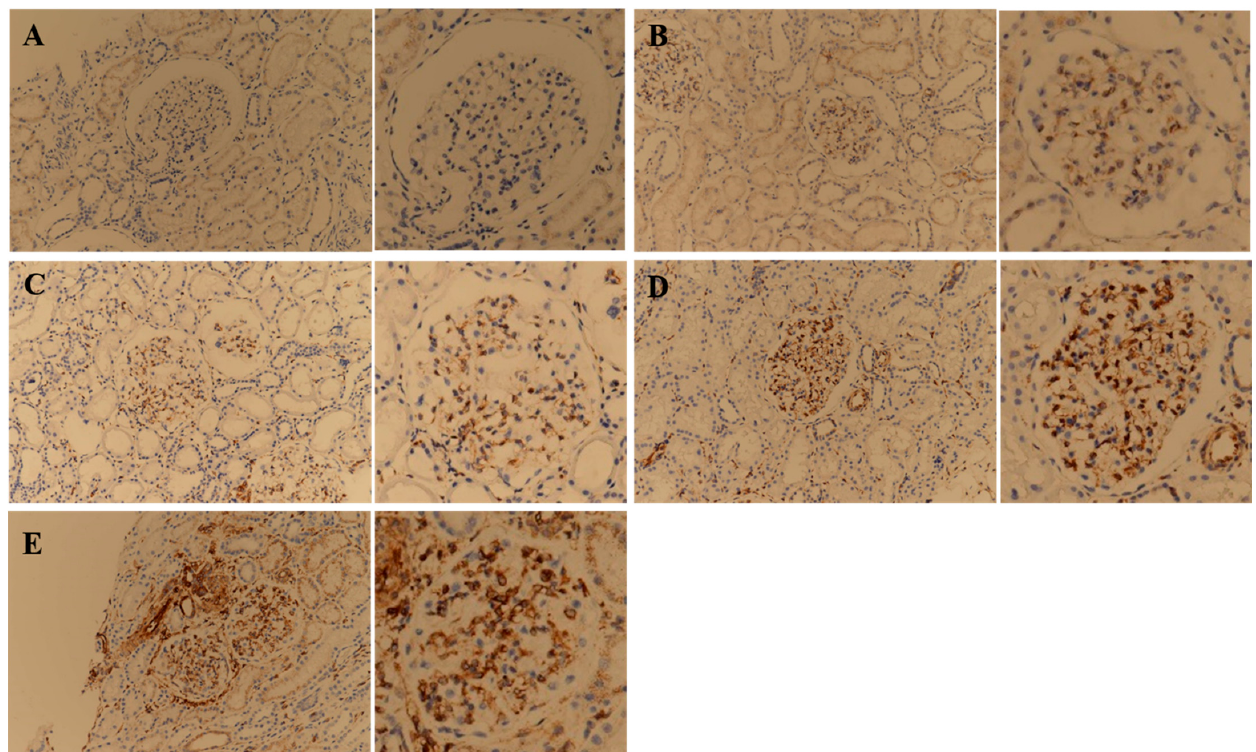
Figure 3. Representative images of immunohistochemical staining of STING on kidney tissue obtained from minimal change disease (MCD) and immunoglobulin A nephropathy (IgAN) patients. Figures of the same glomerulus at a higher magnification are presented to the right of each corresponding figure. MCD patients were classified into negative ( A ), 1+ ( B ), 2+ ( C ), and 3+ ( D ) according to the immunohistochemistry signal intensity. For comparison with MCD patients, an image of the STING IHC stain of the most characteristic patient with IgAN was presented ( E ). Table 2. Site of STING immunohistochemistry stain of the MCD and IgAN groups in the retrospective study.